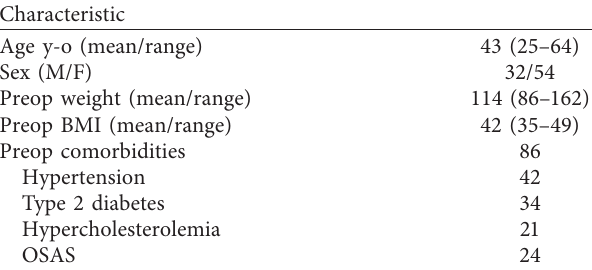
Table 1: Baseline patient demographics.